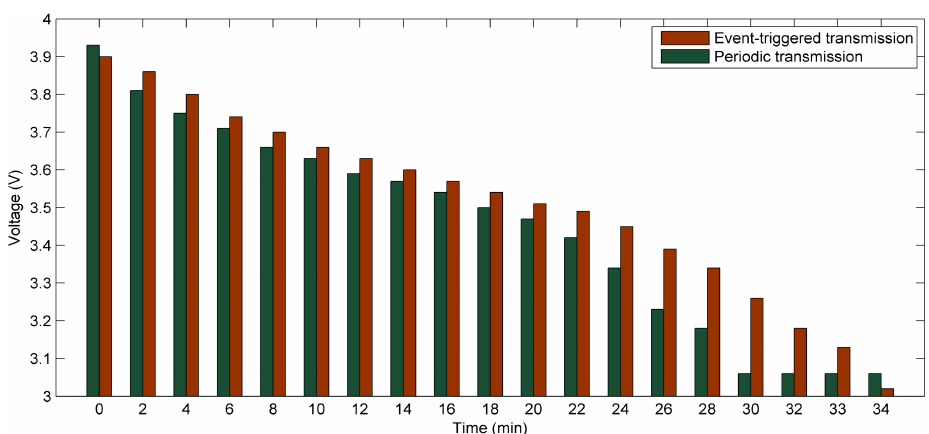
Figure 8. The relationship between time and voltage for periodical and event-triggered